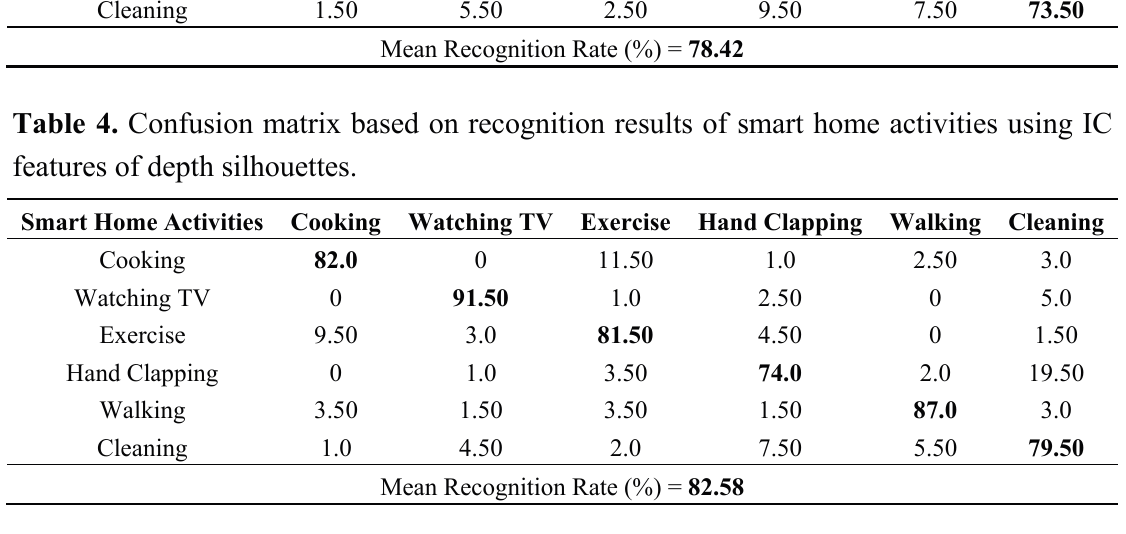
Table 5. Confusion matrix based on recognition results of smart home activities using the proposed motion features of depth